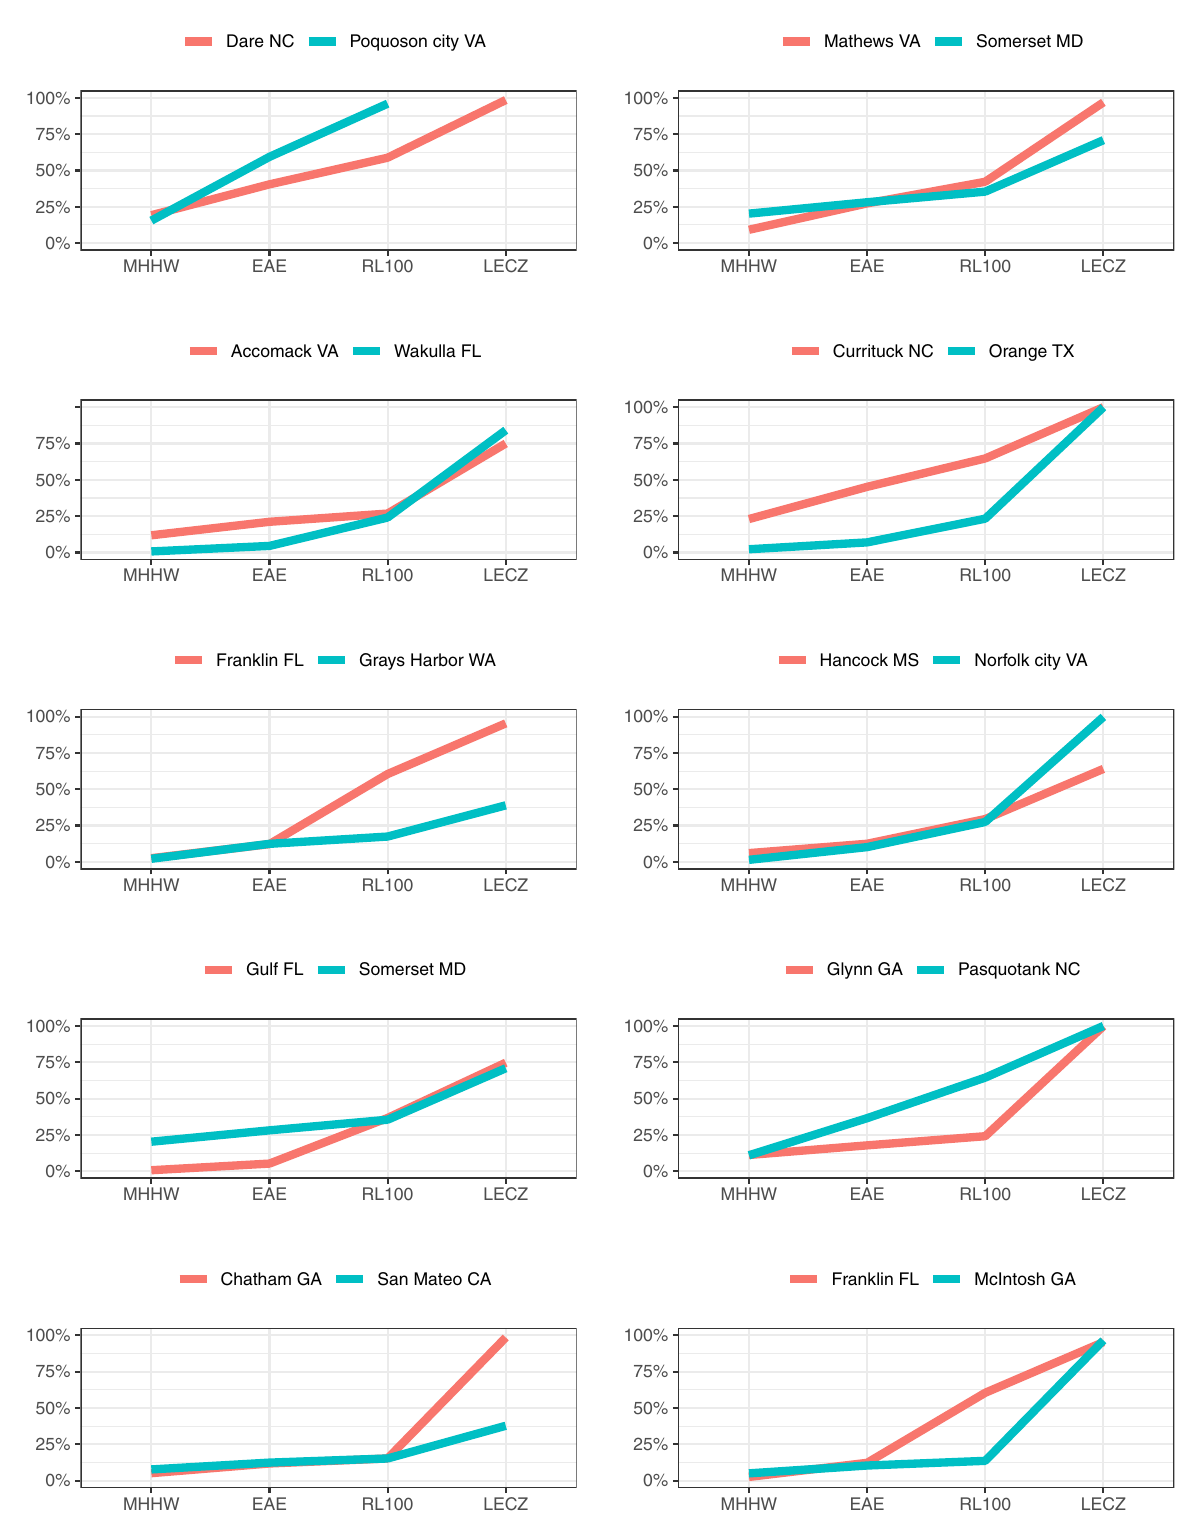
Fig. 3 The percentage of the projected 2100 population under Shared Socioeconomic Pathway 2 (SSP) and Representative Concentration Pathway 4.5 (RCP) under the four spatial-temporal zones representative of sea-level rise impacts. Here we compare counties with similar exposures under different spatial zones to show similarity in one zone does not translate to similar exposure under a different spatial zone. MHHW is the Mean Higher High Water, EAE is the expected annual exposure, RL100 is the 100-year Floodplain, and LECZ is the Low-Elevation Coastal